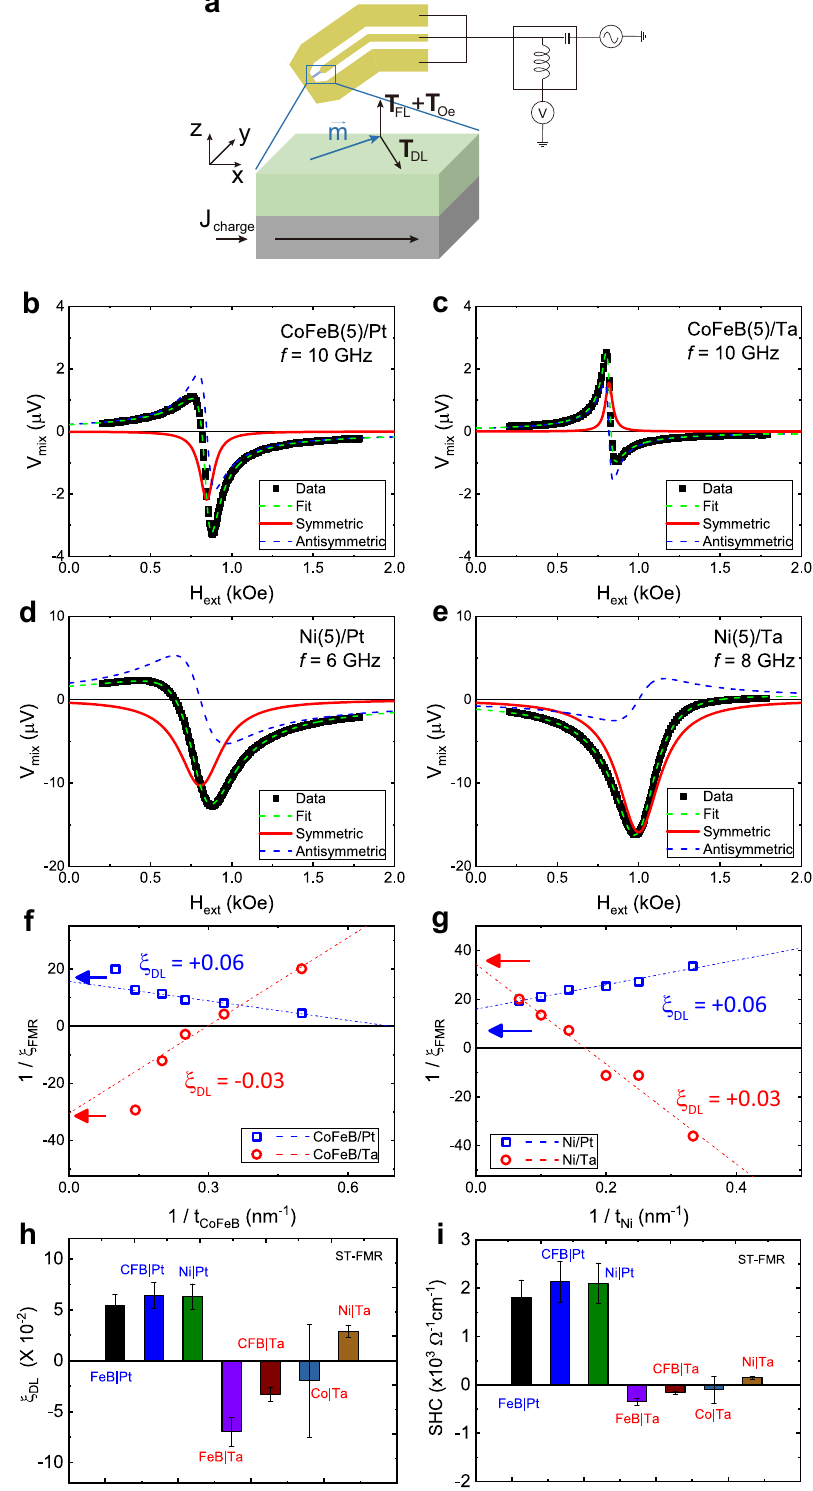
Fig. 3 ST-FMR results of FM/NM bilayers (FM = CoFeB, Ni, NM = Pt, Ta). a A schematic illustration of ST-FMR measurement. b – e V mix ð H Þ of CoFeB(5)/ Pt ( b ), CoFeB(5)/Ta ( c ), Ni(5)/Pt ( d ), and Ni(5)/Ta ( e ) bilayers. Symbols are experimental results and lines are fi tting results with Eq. (1). f, g 1 = ξ FMR as a function o f 1 = t of CoFeB( t )/NM ( f ) and Ni( t )/NM (NM = Pt, Ta) ( g ). h The damping-like torque ef fi ciency ξ FM CoFeB Ni CoFeB, Co, Ni, NM = Pt, Ta). i The effective spin Hall conductivity ( σ DL ) for various bilayers. The error bars in ( h ) and ( i ) indicate single-standard-deviation uncertainties from the fi